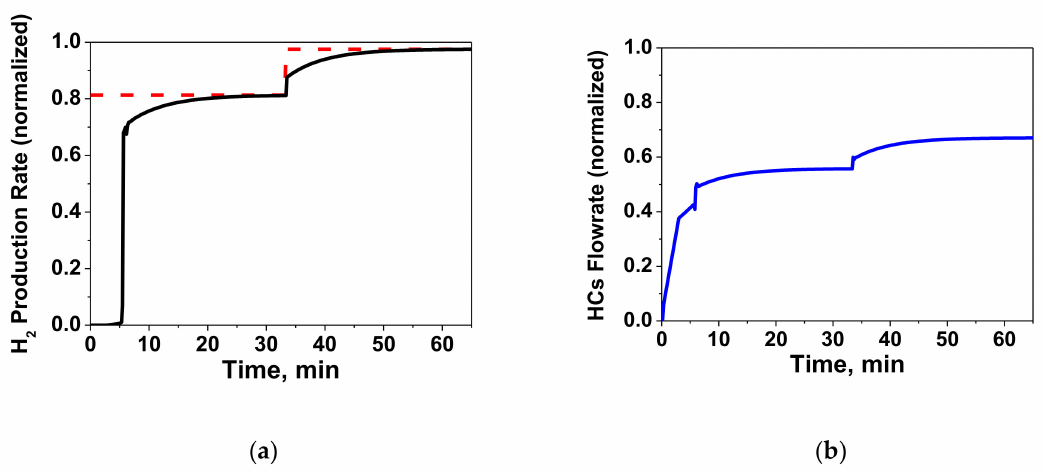
Figure 7. ( a ) H 2 production rate (FC1 controller) and ( b ) HCs flowrate manipulation at the